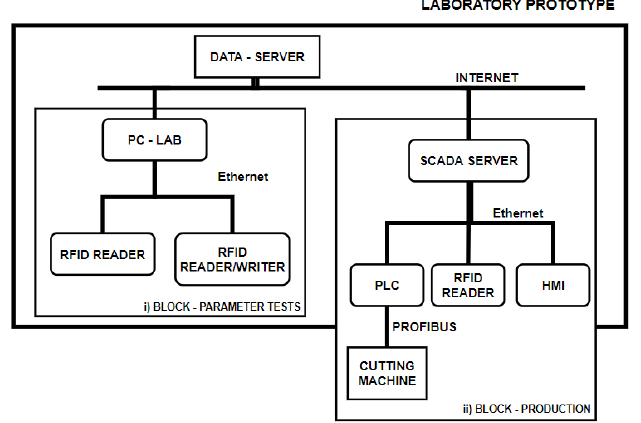
Figure 9. Communications strategy in the Laboratory Prototype: i) Block-Parameter Tests and ii)